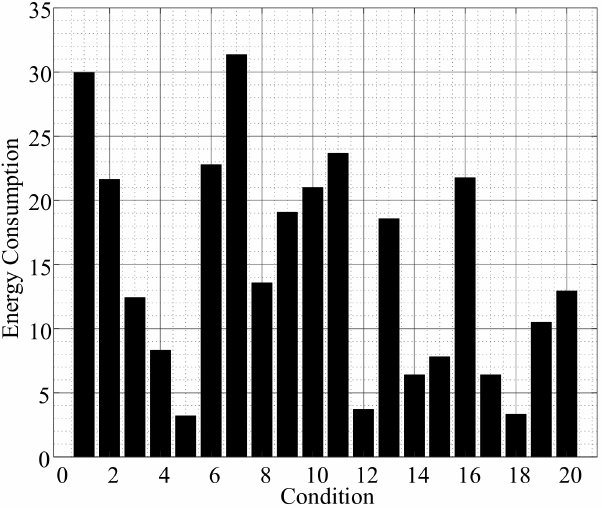
Figure 19. Energy for eighth line